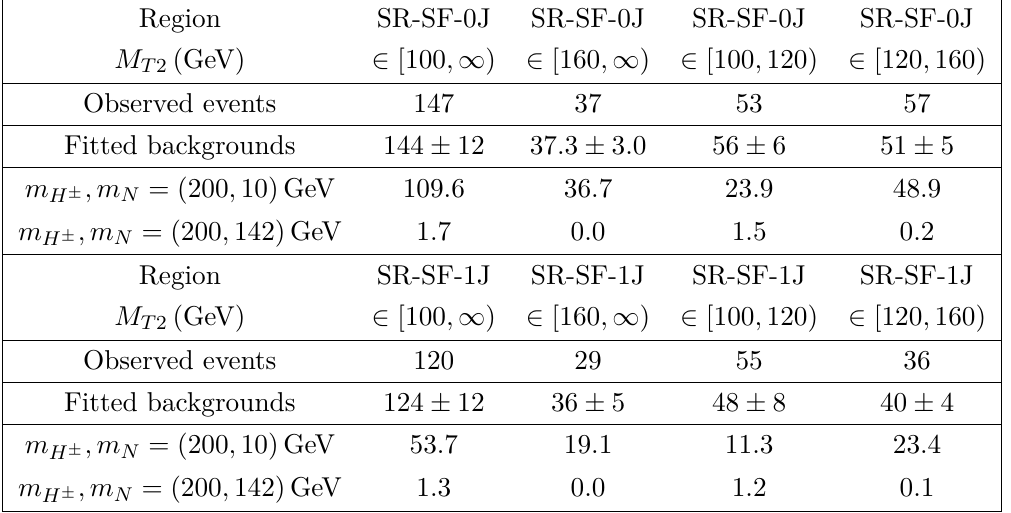
Table 3 . Observed and expected background event yields for the ‘same flavor’ (SF) inclusive signal regions SRs (those numbers are taken from [48]). For reference, we show the number of events in the SRs for few benchmark points in our model corresponding to ( m (200 , 10) , and(200 , 142)